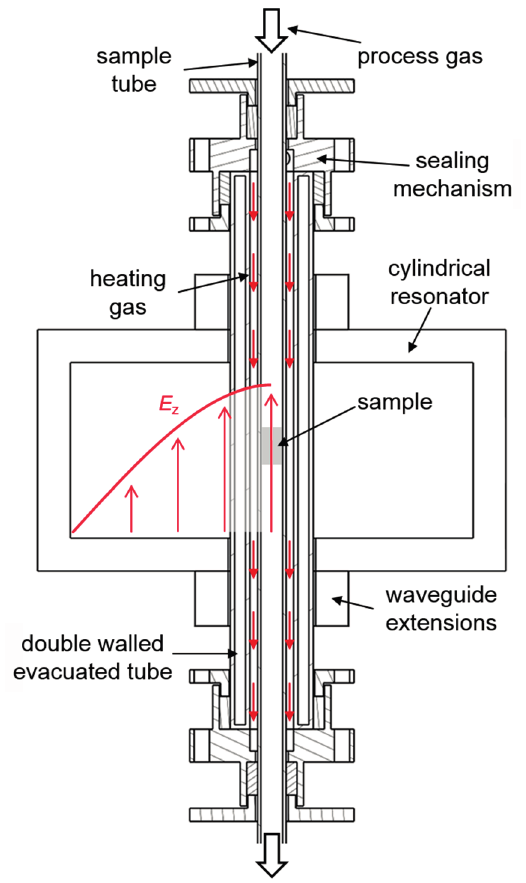
Figure 5. Scheme of the test setup including the sample tube, the glass tube system with sealing mechanism, the resonator with waveguide extensions, loop antennas, and two thermocouples. Reprinted from